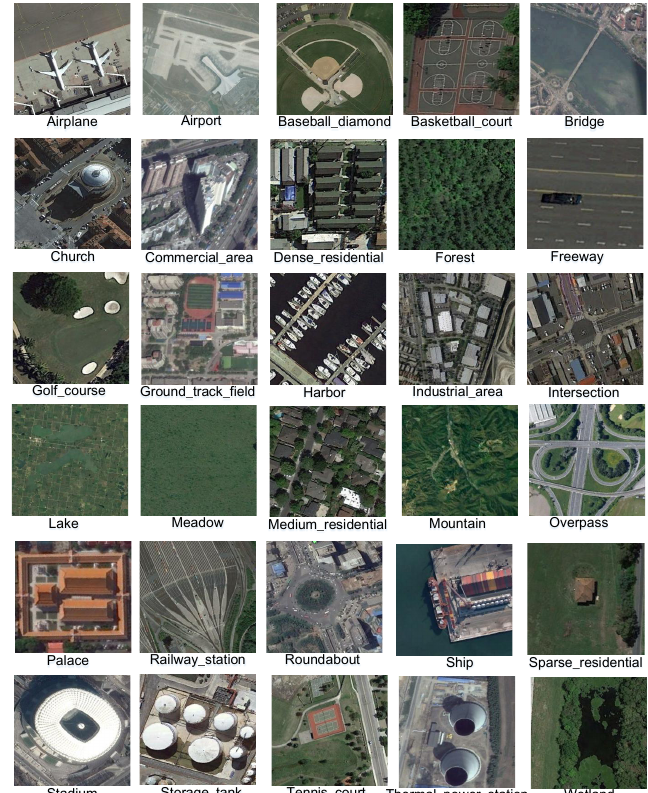
Figure 12. Examples of 30 classes in URSIS dataset.